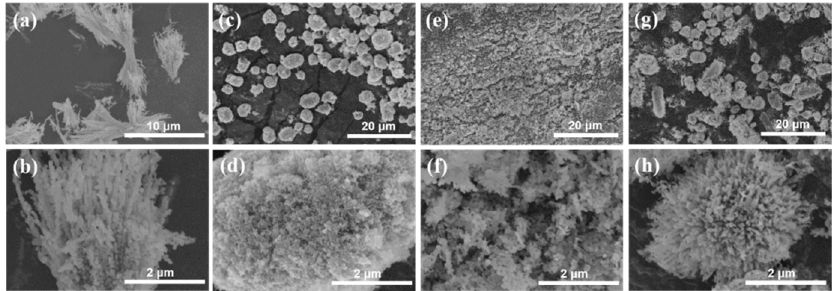
Figure 4. SEM images of the calcinated products related to ( a,b ) Co 3 O 4 -Cl, ( c,d ) Co 3 O 4 -SO 4 , ( e,f ) Co 3 O 4 -AC, and ( g,h ) Co 3 O 4 -NO 3 .